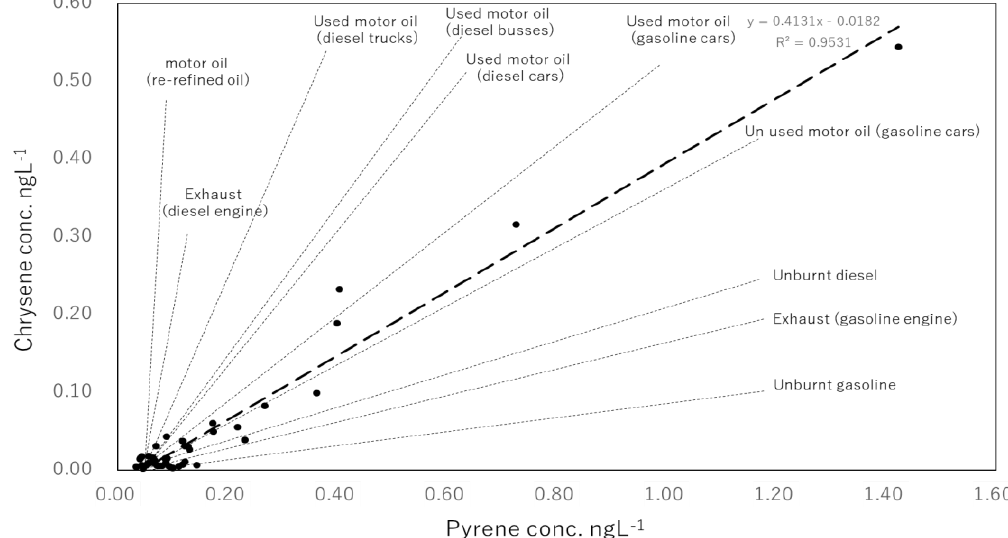
Figure 8. Co-variance ((r = 0.953, n = 43) of chrysene and pyrene of at the interannual survey in North Nanao Bay, Noto Peninsula.